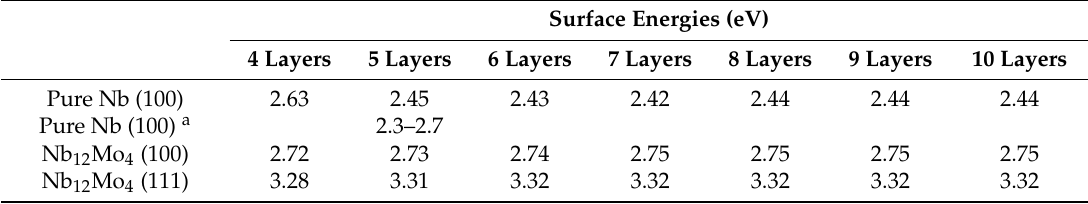
Table 1. Calculated surface energies of pure Nb (100), Nb 12 Mo 4 (100) and (111) for of different numbers of atomic layers. Experimental value [43] is listed for comparison.